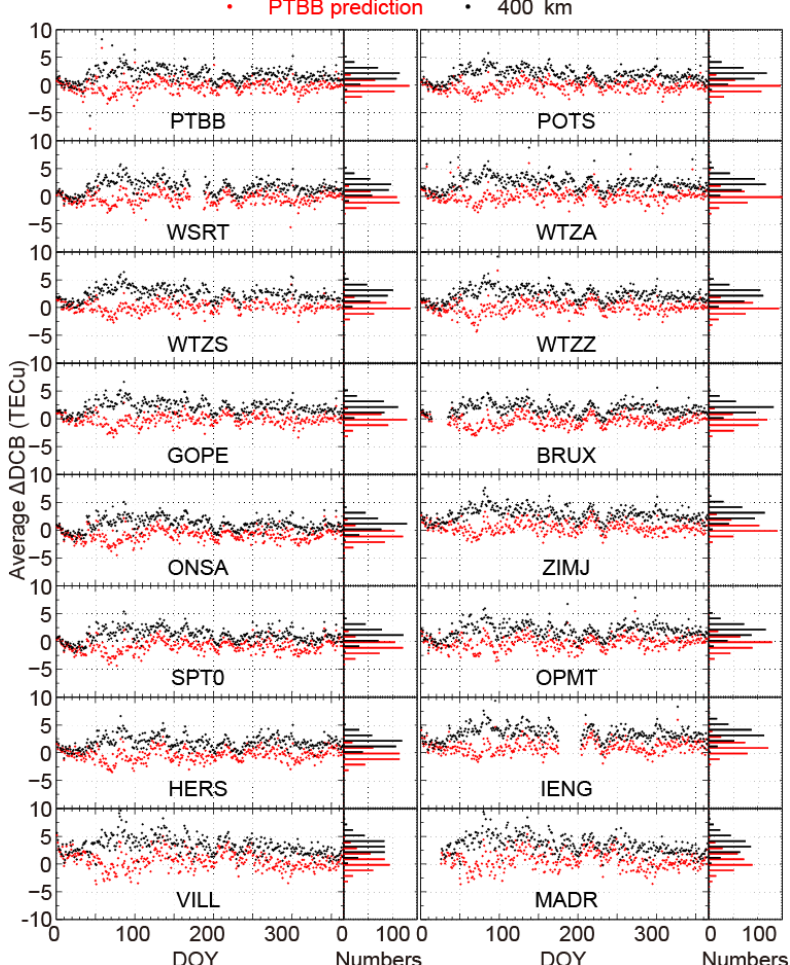
Figure 5. Comparisons of the average (cid:49) DCB calculated using the predicted optimal ionospheric shell heights (red dots) and those using the fixed ionospheric shell height (black dots) in 2014 for stations in Region